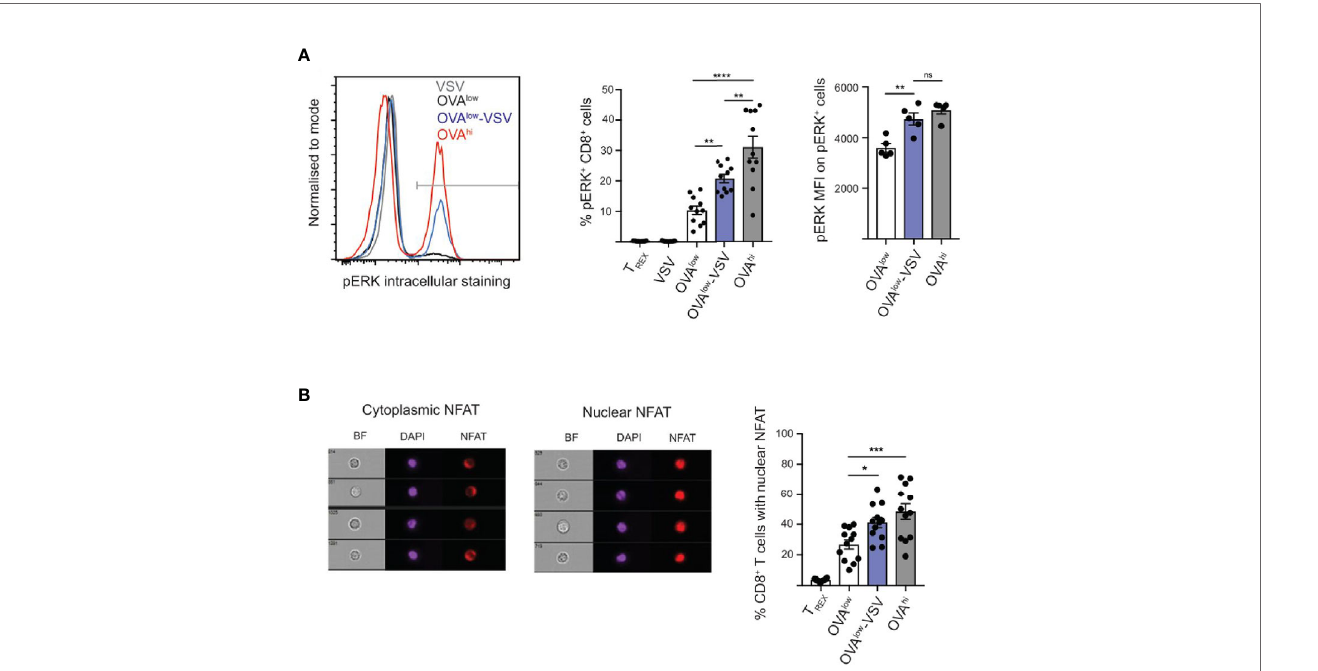
FIGURE 5 | Co-agonism enhances ERK phosphorylation and NFAT nuclear translocation. Ex vivo OT-I lymphocytes were stimulated with the indicated CHO APCs for 3h (A) or 6h (B) , followed by fi xation and intracellular staining to detect pERK (A) or NFAT (B) , and analysis using fl ow cytometry (A) or imaging fl ow cytometry (B) . (A) Data from 10 mice from 3 independent experiments (%) or 4 mice from 1 experiment, representative of 3 experiments (MFI). (B) Imaging fl ow cytometry images showing representative CD8 + T cells with cytoplasmic and nuclear NFAT. Data from 12 mice. Statistical signi fi cance was calculated using one-way ANOVA, with Tukey ’ s multiple comparisons test. *P < 0.05, **P < 0.01, ***P < 0.001, ****P < 0.0001, ns, P ≥